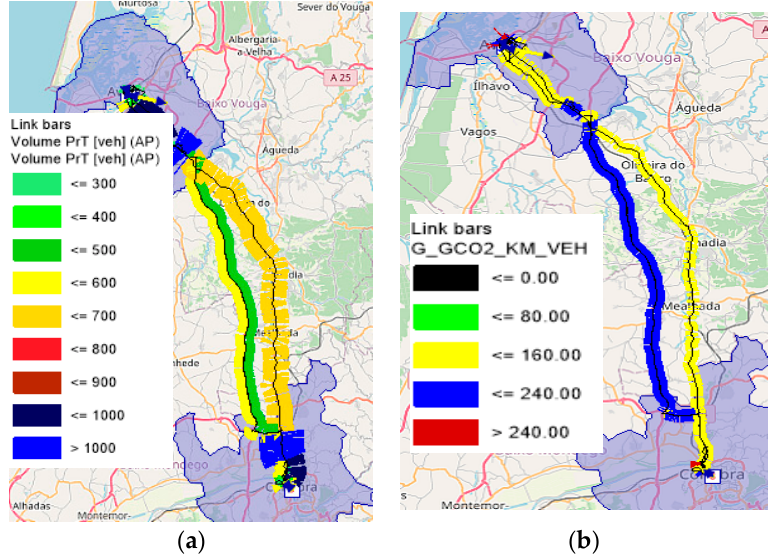
Figure 3. Results obtained for the baseline scenario: ( a ) the number of vehicles; ( b ) specific CO 2 emissions for a petrol car.